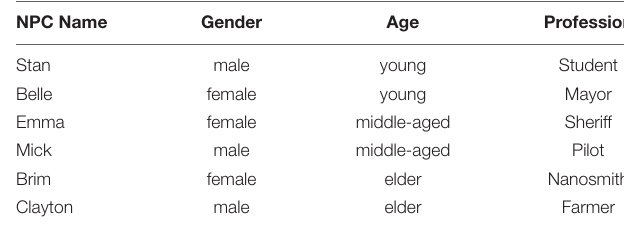
TABLE 1 | The six NPCs in the game and their